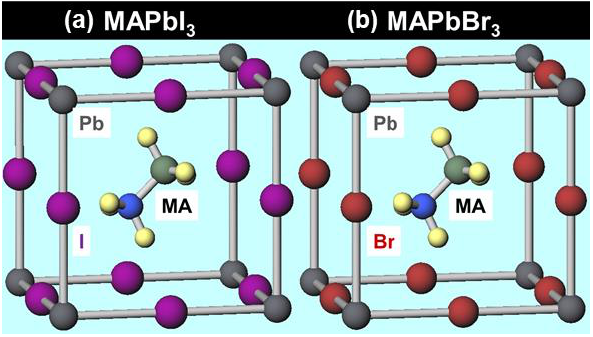
Figure 1. Structure models of ( a ) MAPbI 3 , ( b ) MAPbBr 3 .